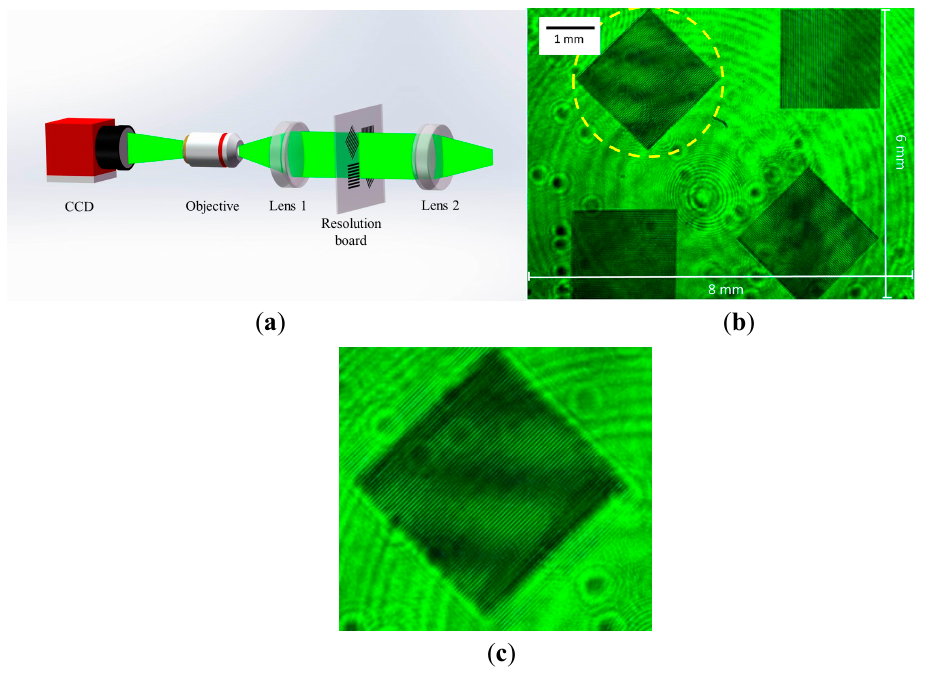
Figure 5. ( a ) Schematic diagram of imaging by CCD, objective and the doublet lens group; ( b ) the captured image corresponds to the blue contour region in Figure 3c; ( c ) the enlarged image of the yellow contour region.